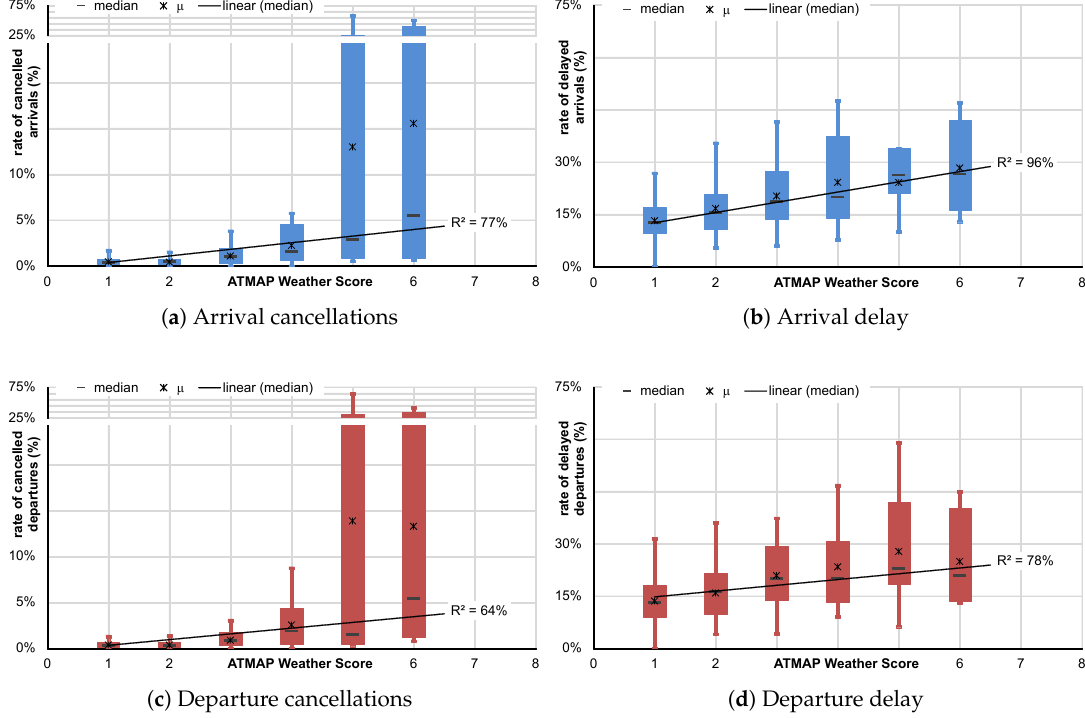
Figure 4. Correlation of ATMAP weather score and cancellation rate for ( a ) arrival and ( c ) departure (please notice the staggered scale) and correlation with the rate of delayed flights ( b ) for arrival and departure ( d ). The ATMAP weather score of n (0 < n < 6) contains all measures between n − 1 and n , the score of 6 contains all values n ≥